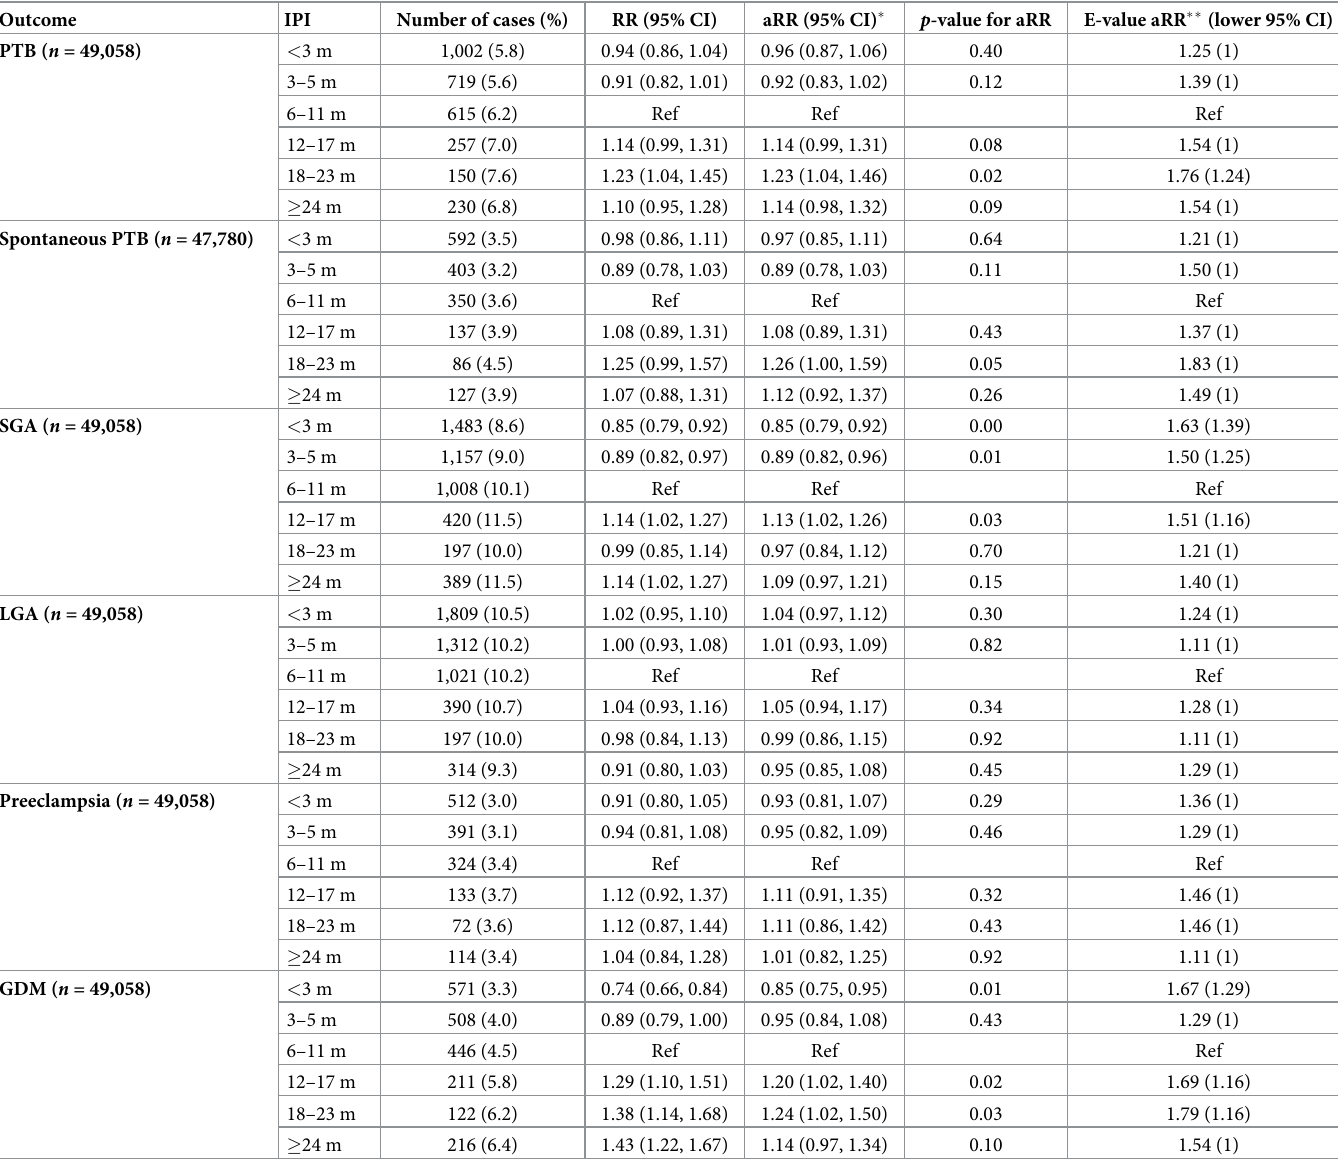
Table 3. IPI after previous miscarriage and risk of adverse pregnancy outcomes for births between 2008 and 2016 in Norway ( n = 49,058). Outcome